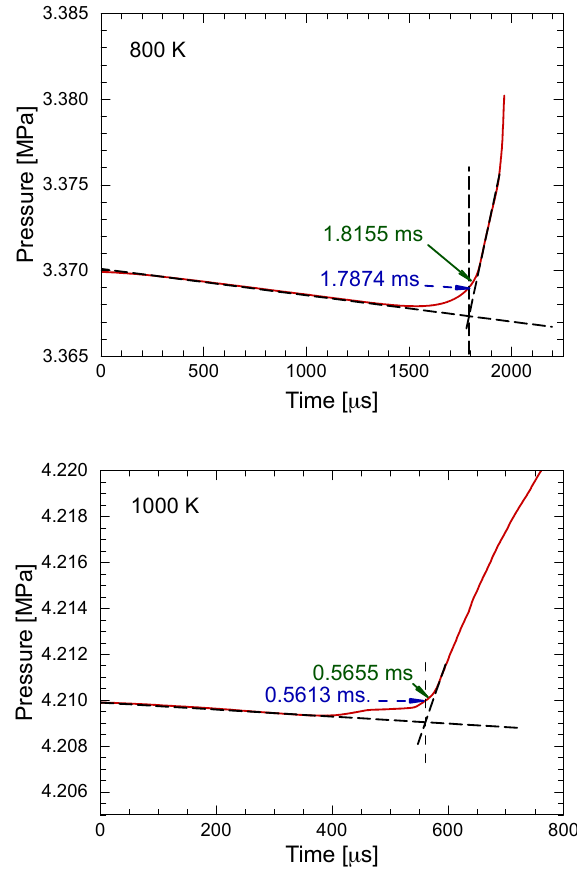
Figure 1. Different definitions of ignition delay (the solid line represents the definition in this study; the dashed line depicts pressure crossover).